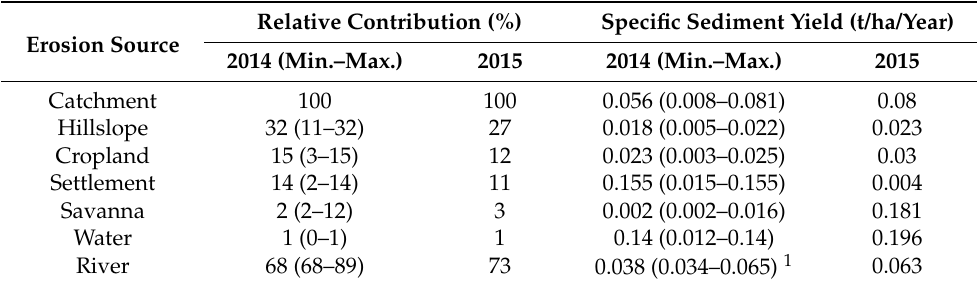
Table 6. Relative contribution and specific sediment yield of the different erosion sources as simulated by the best SHETRAN run for the year 2014 (calibration) and 2015 (validation). Min. and max. indicate the ranges of the ten considered